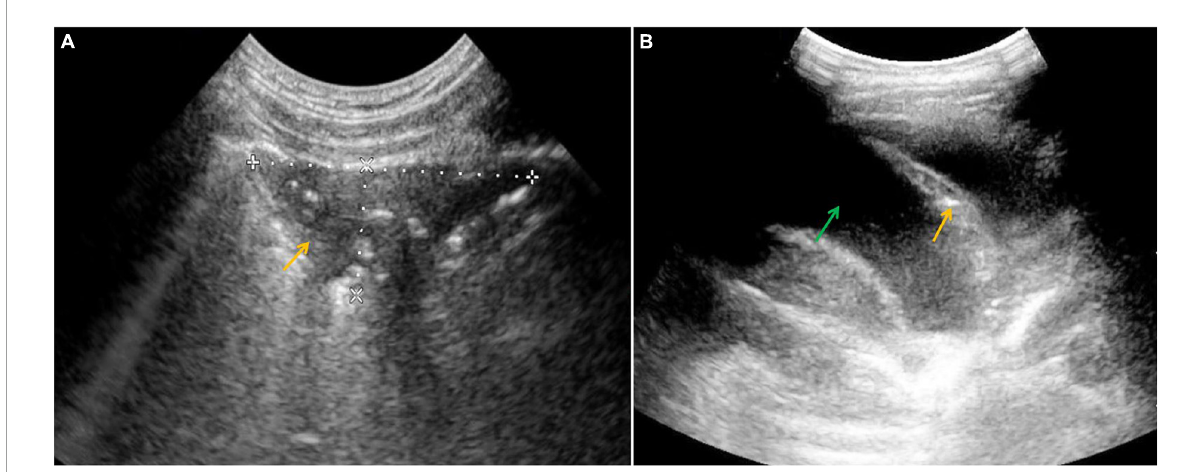
FIGURE2 Ultrasound (US) examination of the lung, convex probe, (A) an area of subpleural consolidation (marked with an arrow), (B) pleural effusion (a green arrow shows the fluid and an orange one shows